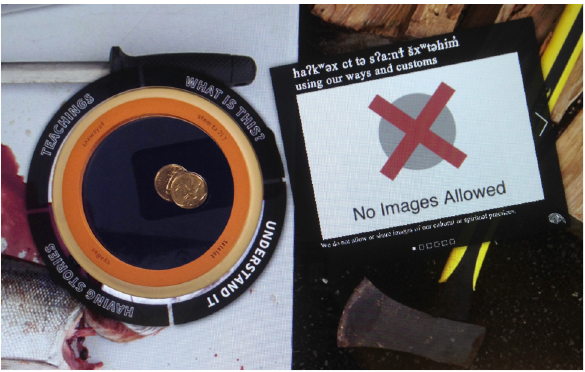
Figure 6 | The quarters connect to the iPhone. Courtesy Reese Muntean.